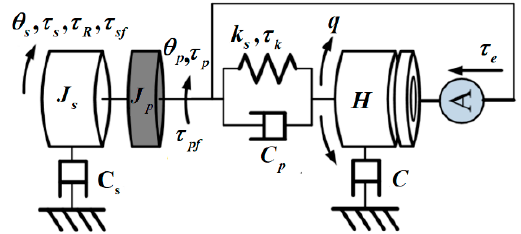
Figure 2. the prototype of variable stiffness joint (VSJ) model.